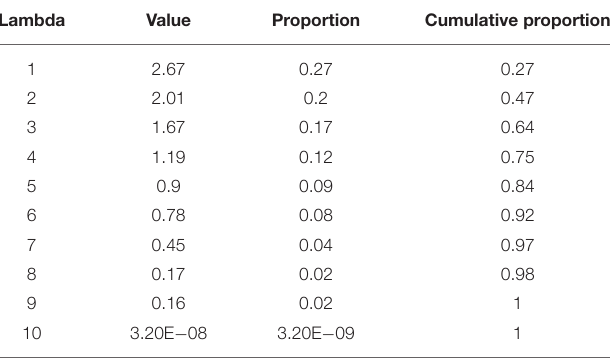
TABLE 4 | Auto-values of the principal component analysis.